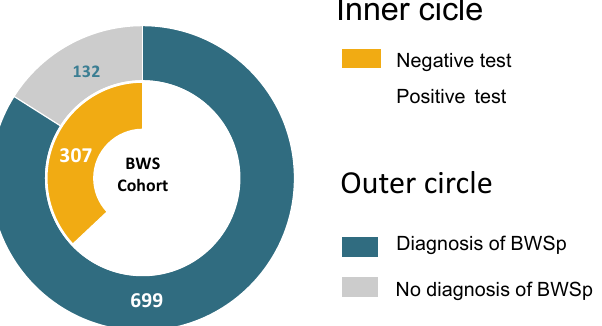
Figure 1. Distribution of the cohort. In the inner circle, patients with a negative test are in yellow, and patients with a positive test are blue; in the outer circle, patients with less than 4 points and a negative test are in gray; patients with a clinical diagnosis and/or positive test are in blue.